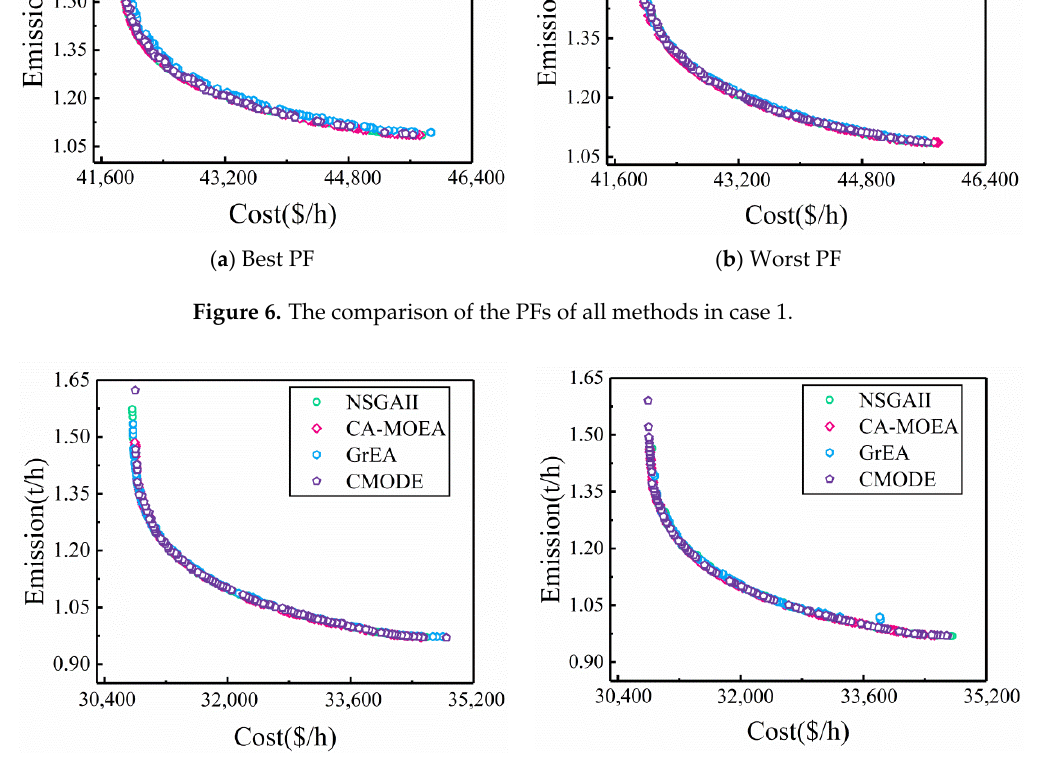
Figure 7. The comparison of the PFs of all methods in case 2.